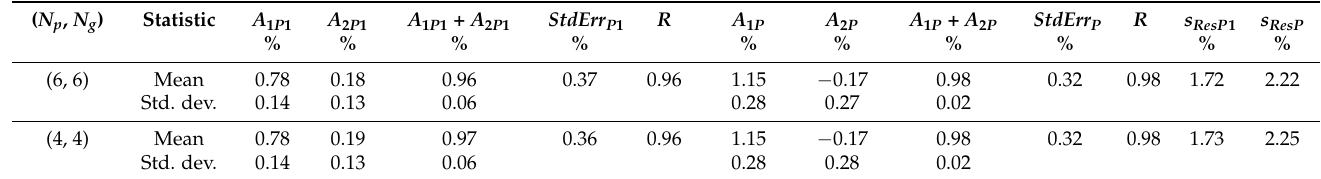
Table 7. Autoregressive model